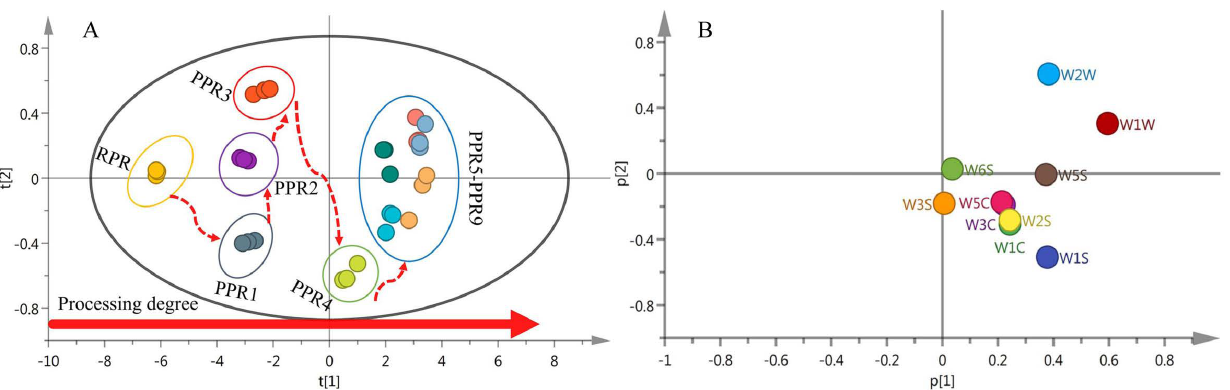
Figure 3. Principal component analysis PCA biplots for 10 different processed PR samples based on E–nose response data: ( A ) Score plot; ( B ) loading plot.